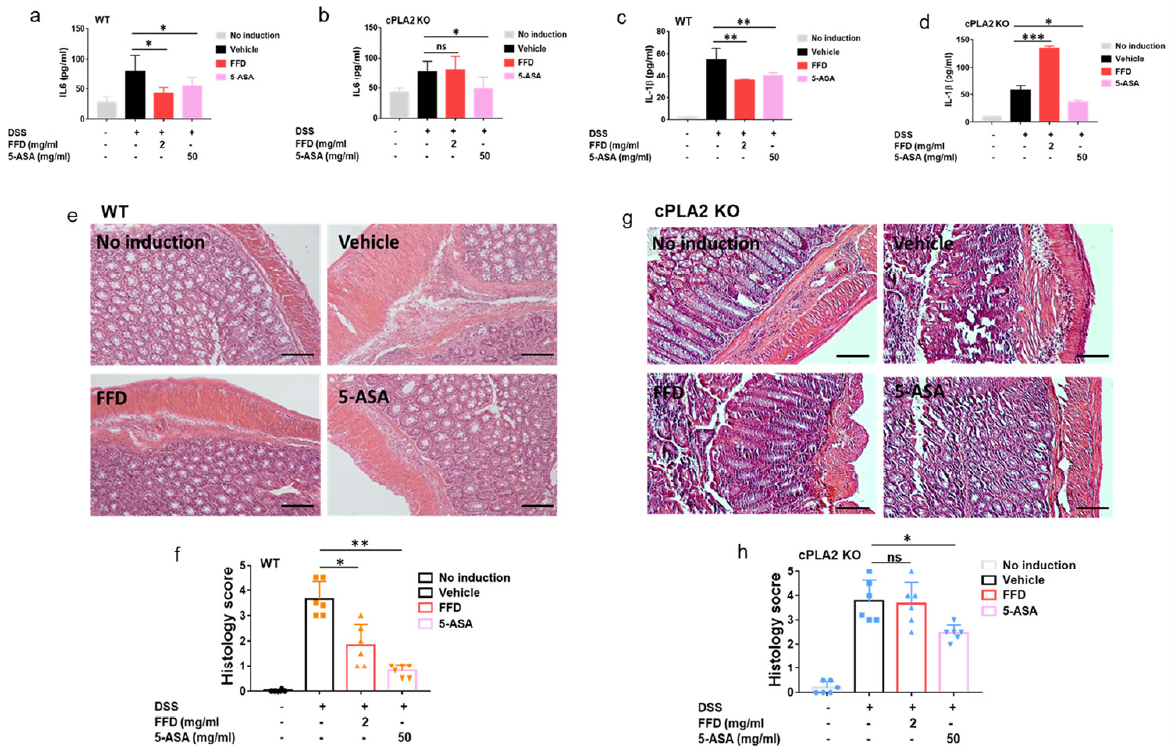
Figure 8. Inflammatory response of Fexofenadine (FFD)-treated or controls in DSS-induced WT or cPLA2 KO mice. ( a – d ) Serum levels of IL-1 β and IL-6. ( a ) Serum level of IL-6 in ctrl, or 5-ASA or FFD-treated WT group. ( b ) Serum level of IL-6 in ctrl, or 5-ASA or FFD-treated cPLA2 KO group. ( c ) Serum level of IL-1 β in ctrl, or 5-ASA or FFD-treated WT group. ( d ) Serum level of IL-1 β in ctrl, or 5-ASA or FFD-treated cPLA2 KO group. ( e , f ) H&E staining and its quantitative analysis in colon tissue sections in ctrl or 5-ASA, or FFD-treated WT group. ( g , h ) H&E staining and its quantitative analysis in colon tissue sections in ctrl or 5-ASA, or FFD-treated cPLA2 KO group. Statistical analysis was done to compare the treatment groups and vehicle groups. n = 6 per group. Data are mean ± SE; * p < 0.05, ** p < 0.01, *** p < 0.001. (Scale bar, 100 µ m). ns: not